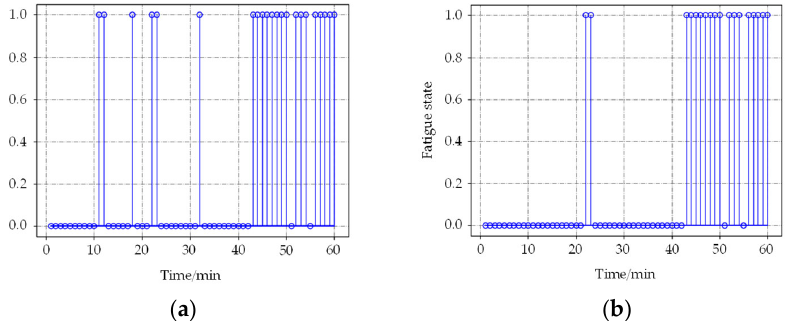
Figure 8. Detection results of the two methods when the time window is 60 s. ( a ) shows results based on the BP neural network; ( b ) shows results based on the time accumulation model.